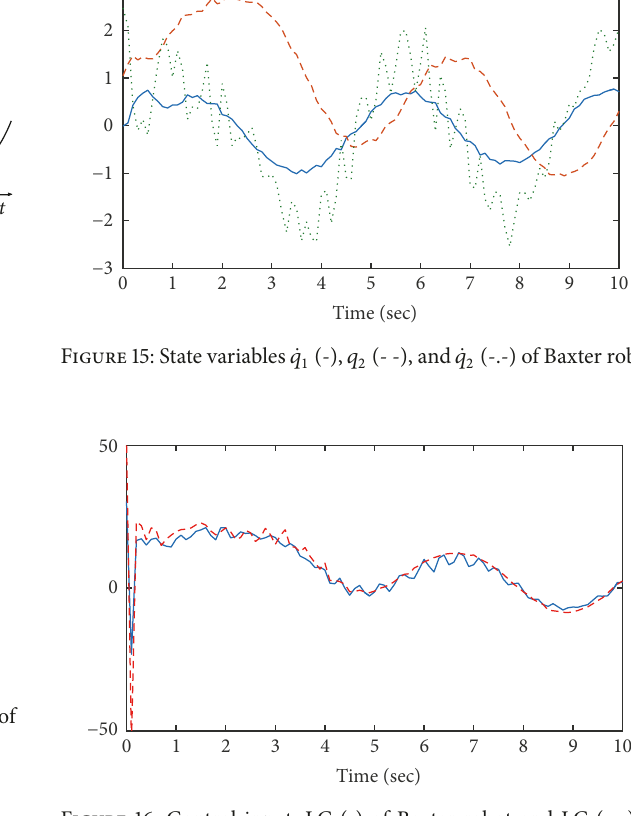
Figure 16: Control input: LC (-) of Baxter robot and LC (- -) of